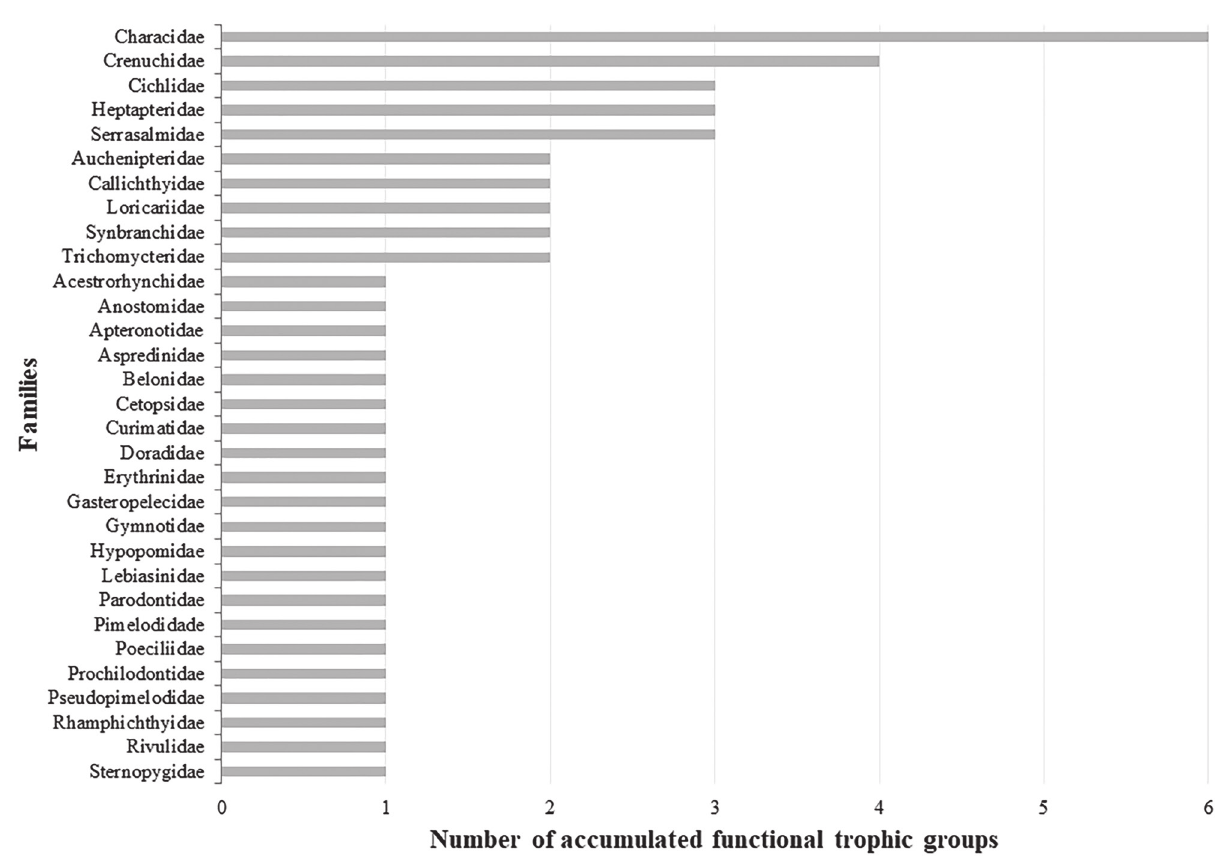
FIGURE 5 | Number of accumulated Functional Trophic Groups by fish families considering Brazilian inland freshwaters works from Sazima (1986), Sabino, Zuanon (1998), Casatti et al . (2001), Brejão et al. (2013), Freitas et al. (2021), and this